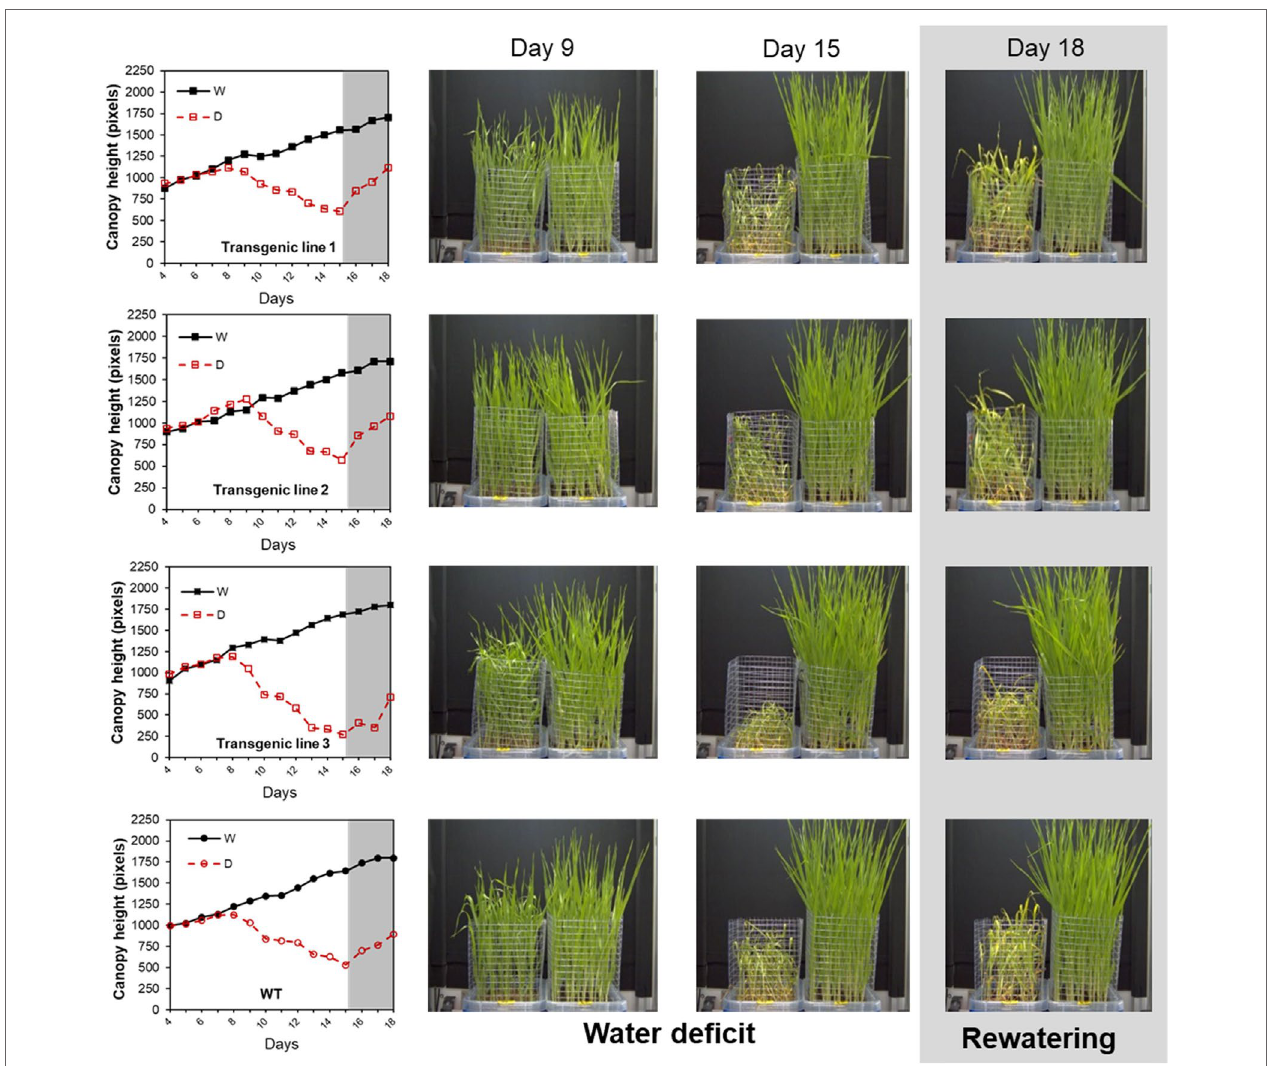
FIGURE 10 | Projected canopy height in barley seedlings from different transgenic lines growing under water stress conditions with subsequent rewatering. Changes in projected canopy height (in pixels) and side view images of the D (left) and W (right) variants of three transgenic lines with silencing transgene A (transgenic lines 1, 2, and 3) and wt during a water stress period and subsequent